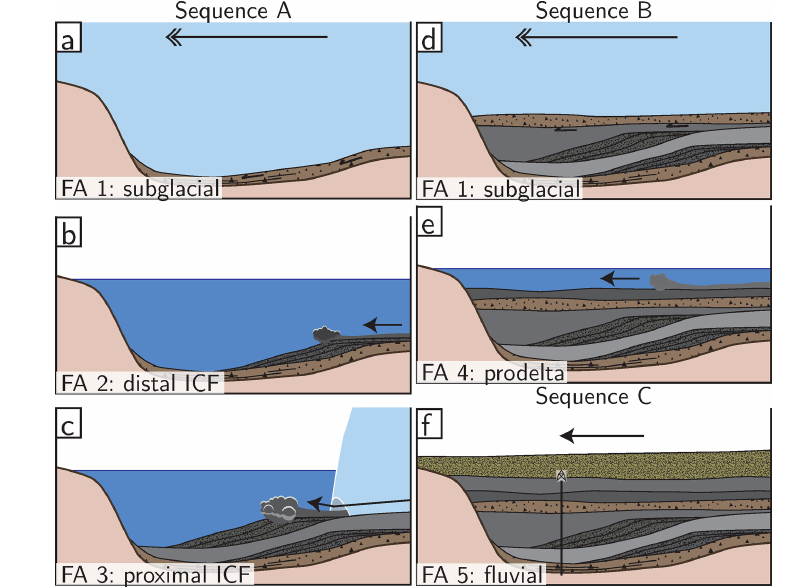
Figure 6. Schematic figures showing the evolution of the Bümpliz trough (Sect. 8.2 and Fig. 1d) as inferred from the retrieved sediment core. The relative core position is indicated by a vertical black line in (f) . The facies assemblages related to each phase in the model are specified in the figures. Glacier ice is colored light blue, ice motion is indicated by a double-headed arrow, lake water is dark blue, and single- headed arrows indicate sediment flow. (a) First glacial advance with bedrock erosion and brittle shearing of the subglacial till. (b) Retreat of the glacier and fining-up aggradation in a distal ice-contact fan (ICF) setting. (c) Deposition of “flow tills” after overcoming a threshold on the lake bed and/or a glacial advance (ICF). (d) Erosion and cutting off foresets due to a second glacial advance with formation of a glaciotectonite (oversteepening). (e) Deposition from underflows in a proglacial lake or from turbulent density flows on a lacustrine prodelta. (f) Overfilled lake basin covered by thick glaciofluvial gravel